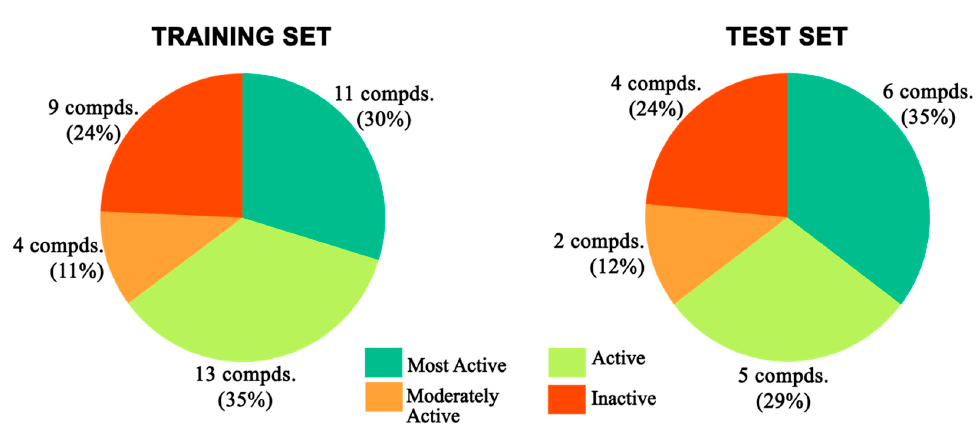
Figure 22. Distribution of different categories of compounds in training and test sets for pharma- cophore modeling.